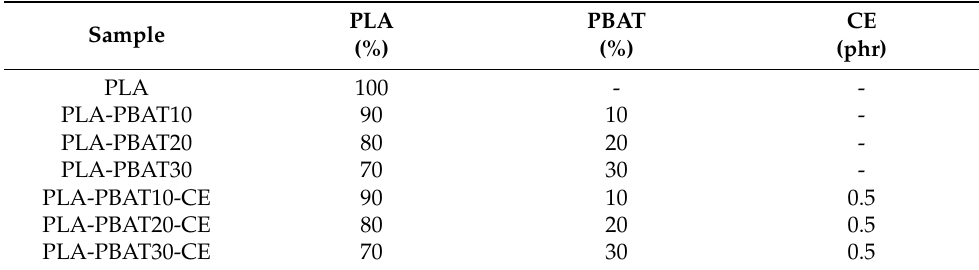
Table 1. The list of the prepared blends with